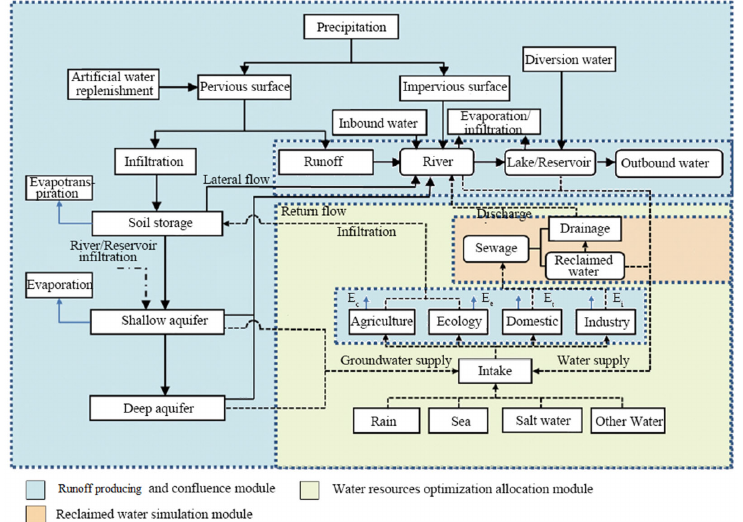
Figure 1. Water allocation and simulation (WAS) model framework.